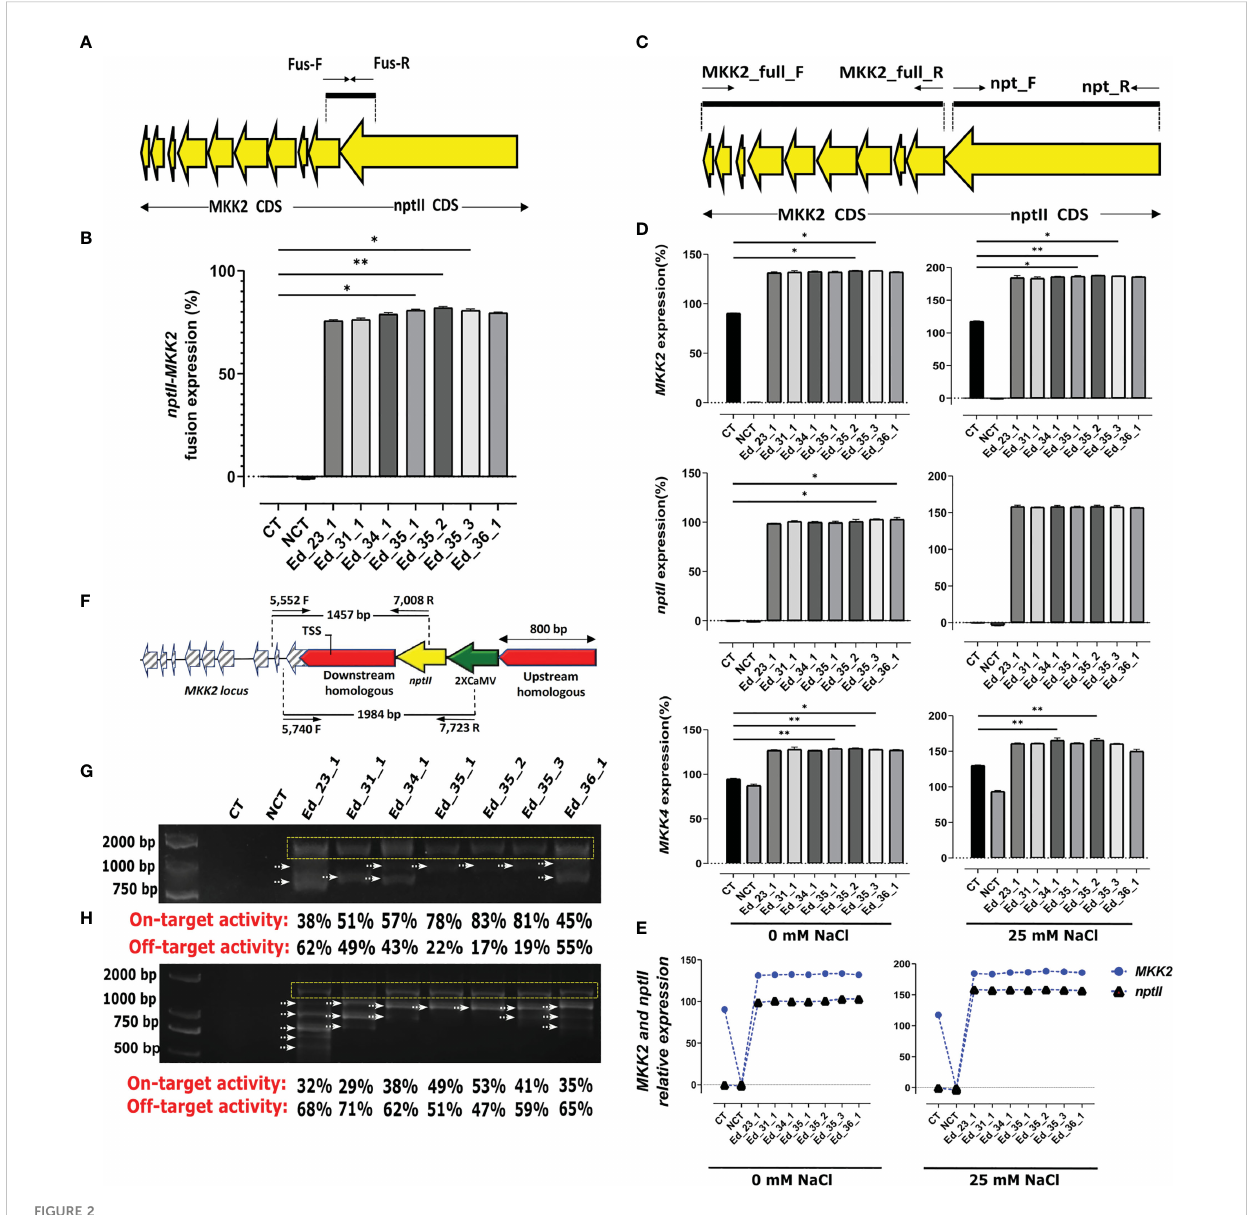
FIGURE 2 Recovered edited events exhibited nptII – MKK2 fusion and proper exogenous and exopromoter integration. (A) Schematic of nptII – MKK2 mRNA fusion. (B) nptII and MKK2 fusion mRNA revealed more expression via recovered events, especially Ed_35_1, Ed_35_2, and Ed_35_3, compared with the CT line. (C) Schematic of complete CDS of nptII and MKK2 through proper HDR. (D) The recovered edited events showed MKK2 , nptII , and the downstream MKK5 more expressions than the CT line under 0 and 25 mM of NaCl treatments. (E) nptII and MKK2 exhibited relative expressions under 0 and 25 mM of NaCl treatments. (F) Schematic of properly integrating nptII and 2XCaMV 35S into MKK2 promoter zone and overexpressed MKK2 driven by 2XCaMV 35S. (G) PCR-ampli fi ed veri fi cation of nptII proper integration and on- and off-target evaluation. (H) PCR-ampli fi ed validation of 2XCaMV 35S proper integration and on- and off-target evaluation. Error bars represent SE; asterisks represent p -values as * ≤ 0.05 and ** ≤